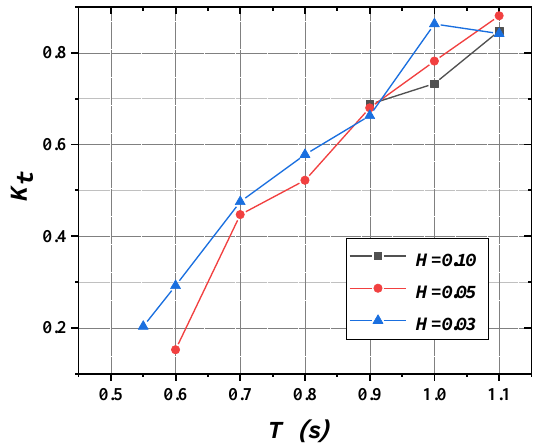
Figure 22. Wave transmission coefficients ( β = 90 ◦ ).